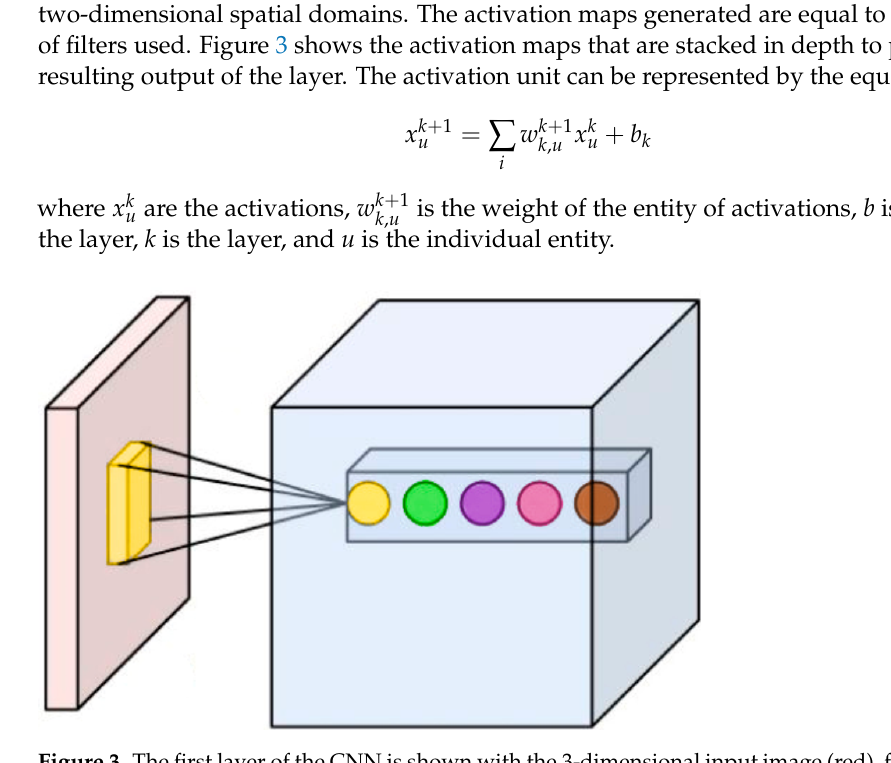
Figure 3. The first layer of the CNN is shown with the 3-dimensional input image (red), filter (yellow), activation map (blue), and five neurons activation (stacked in-depth dimension for the same region of filter convolution (yellow) with the input image) resulting from five filters of the corresponding colors (yellow, green, pink, purple, and brown)